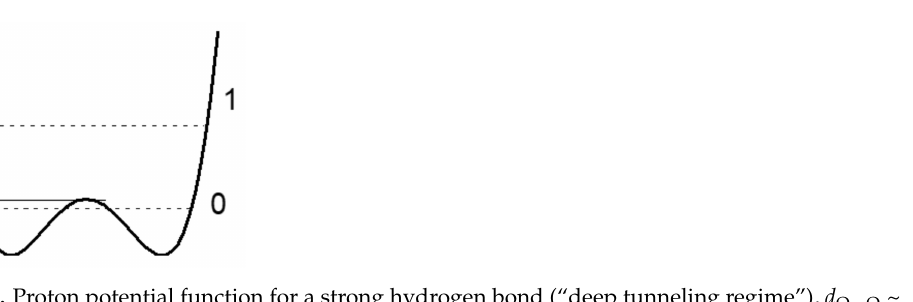
Figure 3. Proton potential function for a strong hydrogen bond (“deep tunneling regime”), d O ··· O ~ 2.5 Å.